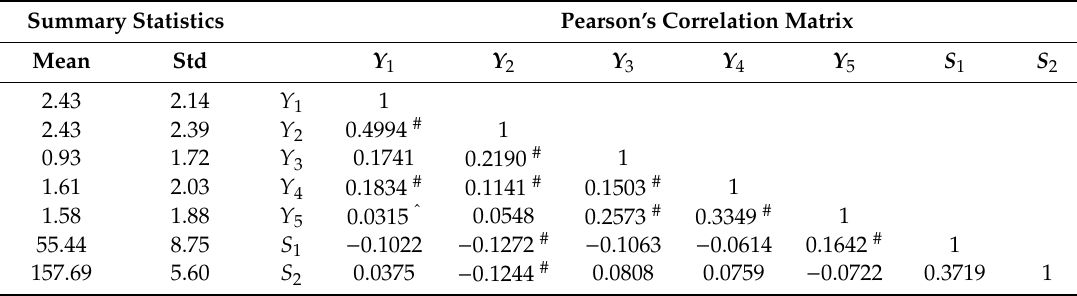
Table 8. Statistical information of the perturbed data using the GADP method. Summary Statistics